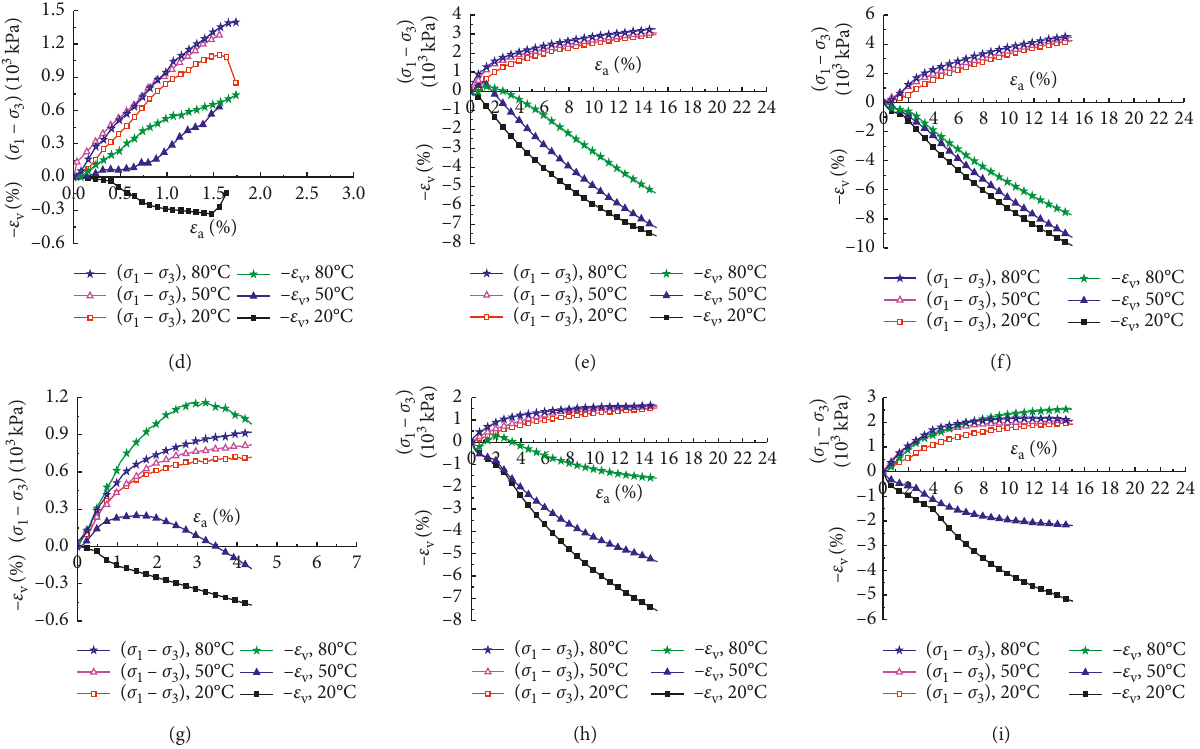
) ∼ ε − σ and ε ∼ ε of the samples under the dry density of 1.4 g/cm 3 with different water contents, 1 3 a v a � 1.4 g/cm 3 , w � 5%, σ � 0 kPa. (b) ρ 3 d